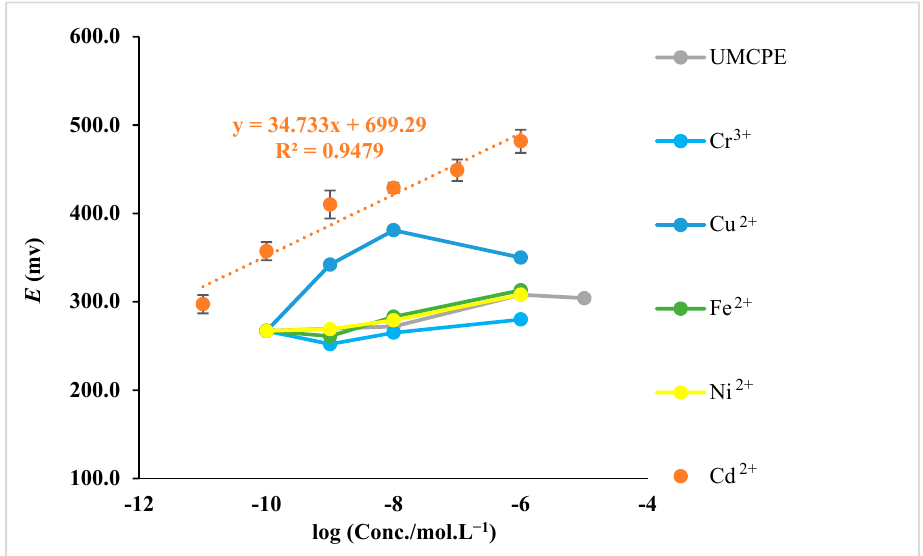
Figure 4. Investigation of B15C5-MCPE selectivity toward Cd 2+ ion and Calibration curve for Cd 2+ ion determination. Experimental conditions: channel containing 0.1 mol·L − 1 KNO 3 in 0.1 mol·L − 1 HAcNaAc buffer pH 5.0; 6B pencil as a pseudo-reference electrode and B15C5-MCPE as an indicator electrode.